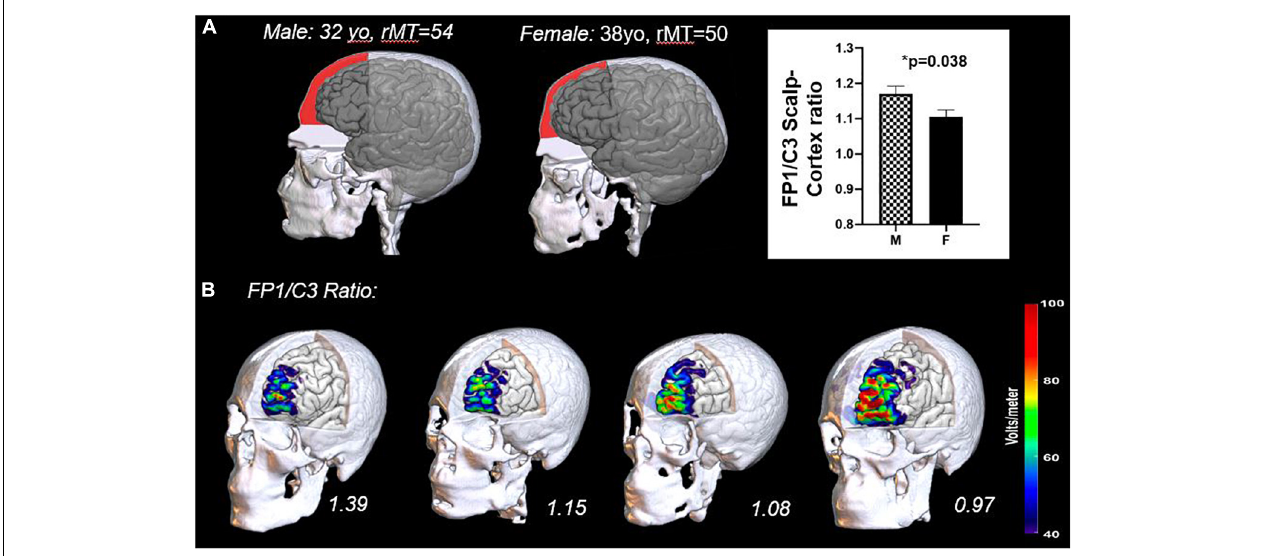
FIGURE 1 | Differences in cranio-facial anatomy in men and women (A) and the impact of these anatomical differences on the TMS induced electrical field at the cortical surface (B) . The frontal bone of men typically has a lower declination angle (slope) and a more prominent brow ridge extending to the lateral prefrontal cortex than women. This results in a larger distance from the scalp to cortex in men relative to women (A) . A representative male and female from a previous study are plotted here with the subdural space from the top of the frontal bone to the level of the nasion shaded (red). Previous data from our laboratory has demonstrated that the scalp-to-cortex distance ratios at the Frontal Pole (FP1) relative to the Motor Cortex (C3) are significantly greater in men (13). The importance of this ratio is underscored by the sensitivity of the TMS induced electric field to small changes in distance (B) . Here we have rendered the TMS induced electric field (110% resting motor threshold) for four individuals in the study–two males (left) and two females (right). In as much as the motor threshold continues to be used as a dosing metric for other cortical areas, it would be prudent to incorporate these ratios into dosing